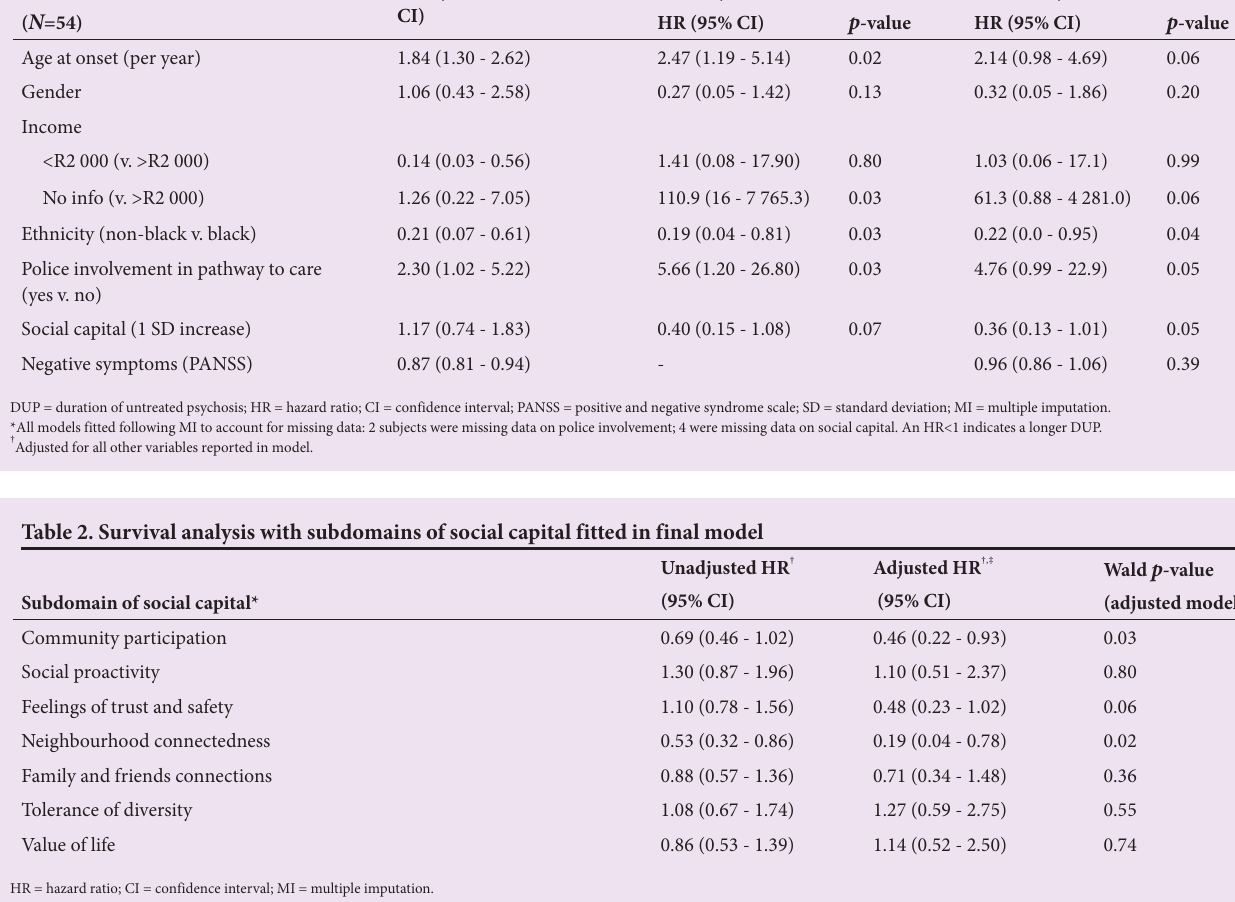
Table 1. Survival analysis using Cox regression to investigate sociodemographic and socio-environmental factors associated with DUP* Risk factor